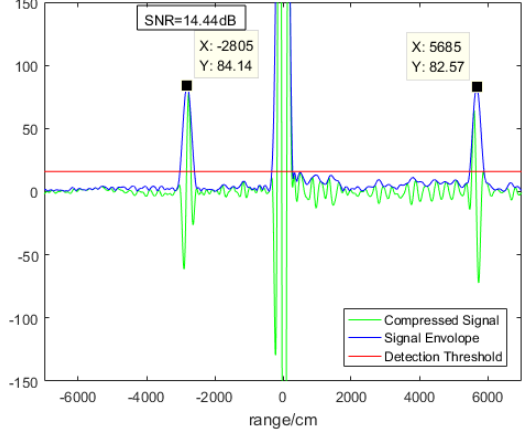
Figure 5. One of the 100 Figure 5 . One of the 100 measurements.